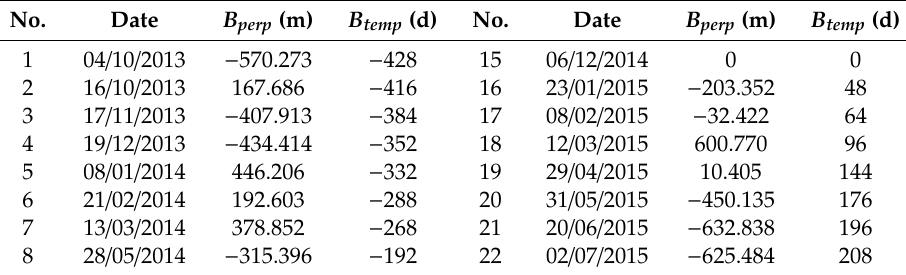
Table 1. Basic information of the 28 -CosmoskyMed descending